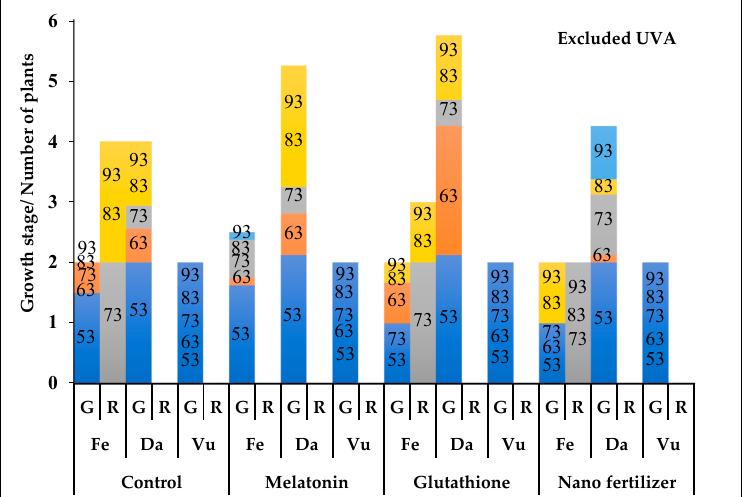
Figure 5. The phenological stages of Thymus fedtschenkoi (Fe), T. daenensis (Da) and T. vulgaris (Vu) under excluded UVA and following application of protectant compounds [water (control), melatonin, glutathione, iron-zinc nanofertilizer]. Both the rate of growth (G) and of rosette (R) are provided. Numbers on the columns represent days after pruning. For G column, the y-axis scale represents the following stages: 0–1, early vegetative stage (active growth or 4–6 leaf stage); 1–2, late vegetative stage (stem development); 2–3, budding stage (20% budding); 3–4, full budding stage; 4–5, early flowering stage; and 5–6, full flowering stage. For R column, the y-axis scale represents the number (out of 4) of rosette